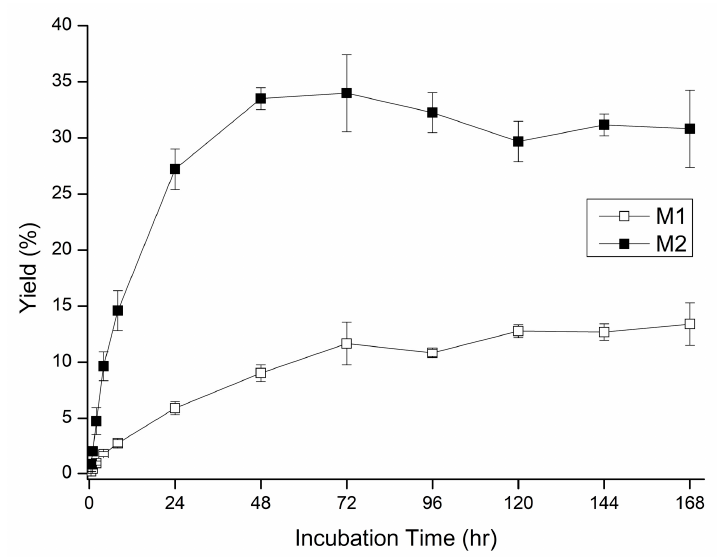
Figure 7. Time course of the glycosylation of mangiferin by Pg MA. The reaction was conducted with 50% ( w / v ) maltodextrin, 5.6 μ g/mL Pg MA, and 1 mg/mL mangiferin at 50 mM of PB (pH 7) and 65 °C. At the interval time, the reaction mixture was analyzed with HPLC. The conditions for HPLC